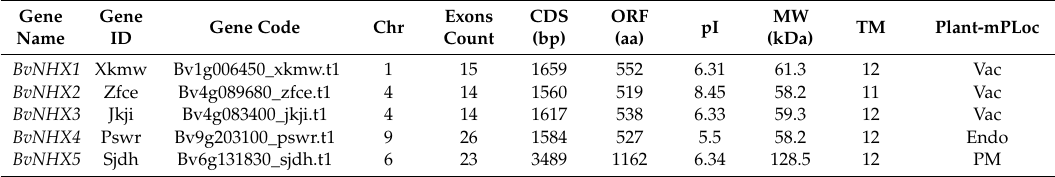
Table 2. Identification of sugar beet BvNHX family genes.